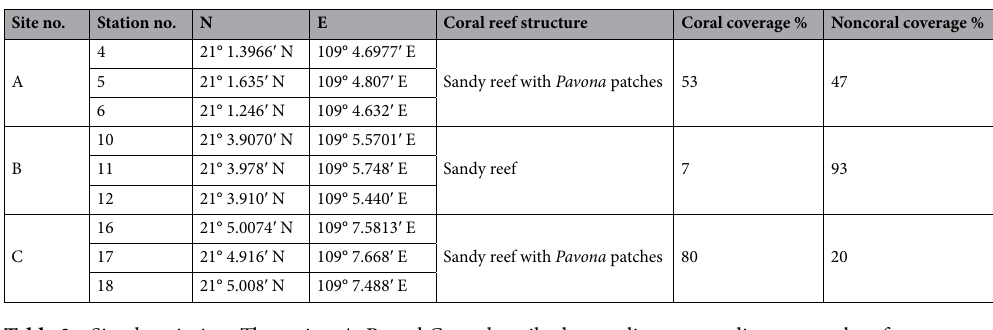
Table 3. Site description: Three sites A, B, and C are described according to coordinates, coral reef structure, coral coverage and noncoral coverage.